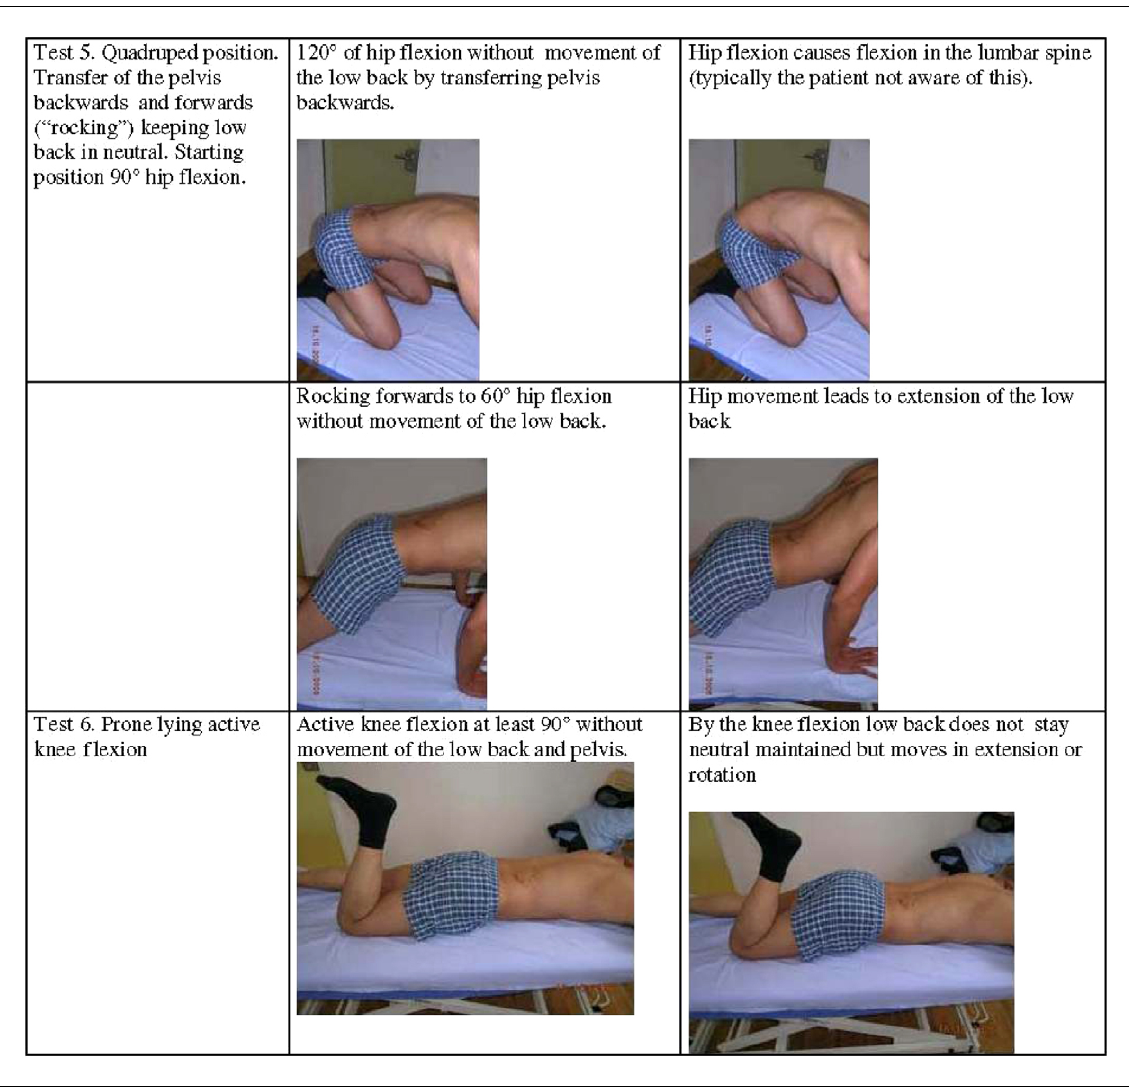
Table 1. characteristics of the study